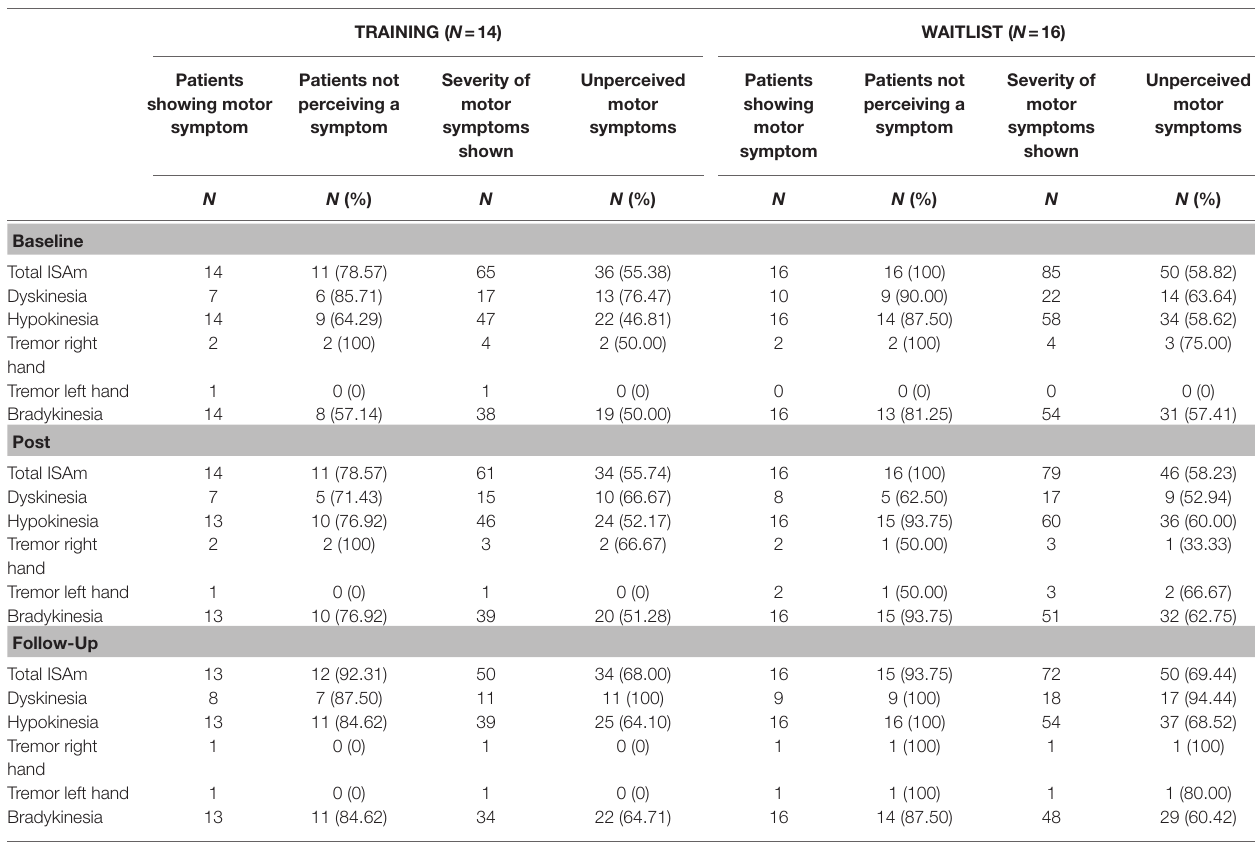
TABLE 4 | Results of the ISAm